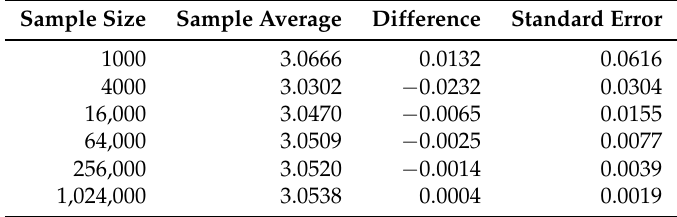
Table 1. Sample average and accuracy of the exact simulation algorithm.